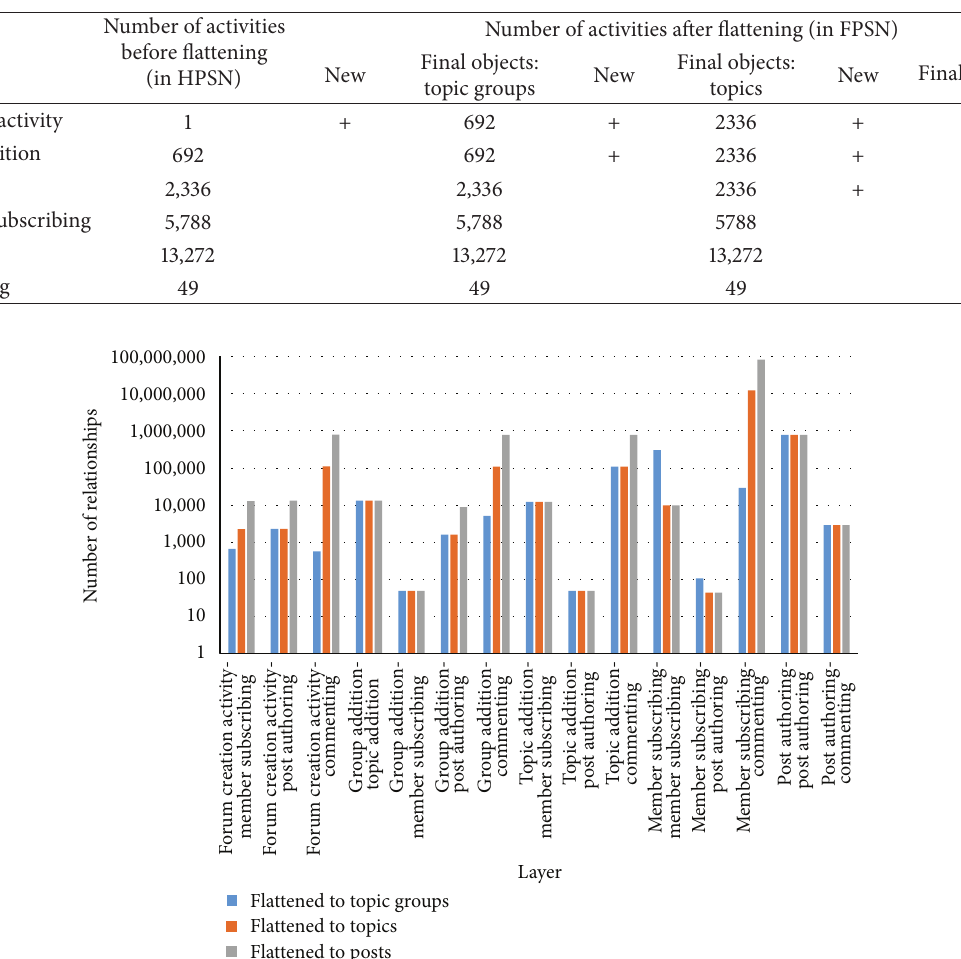
Table 4: Number of activities before and after flattening; “+” denotes activates which were created during a given flattening process.